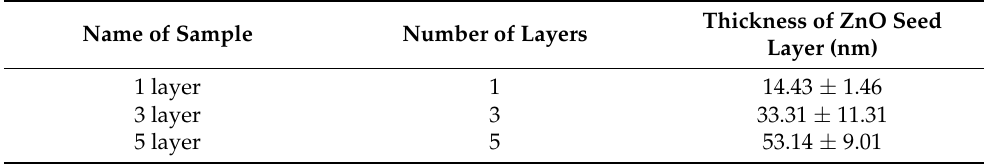
Table 1. Features of multilayer ZnO thin film deposited by a sol-gel spin coating